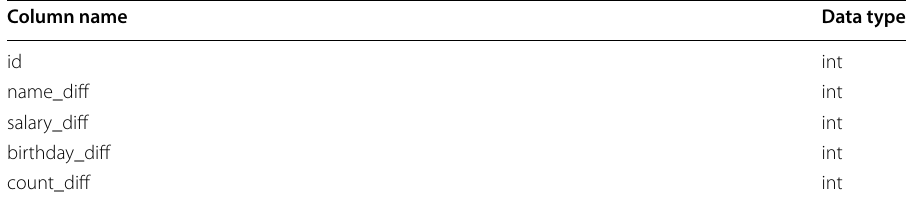
Table 8 Validation database schema—“Users_col_delta" table